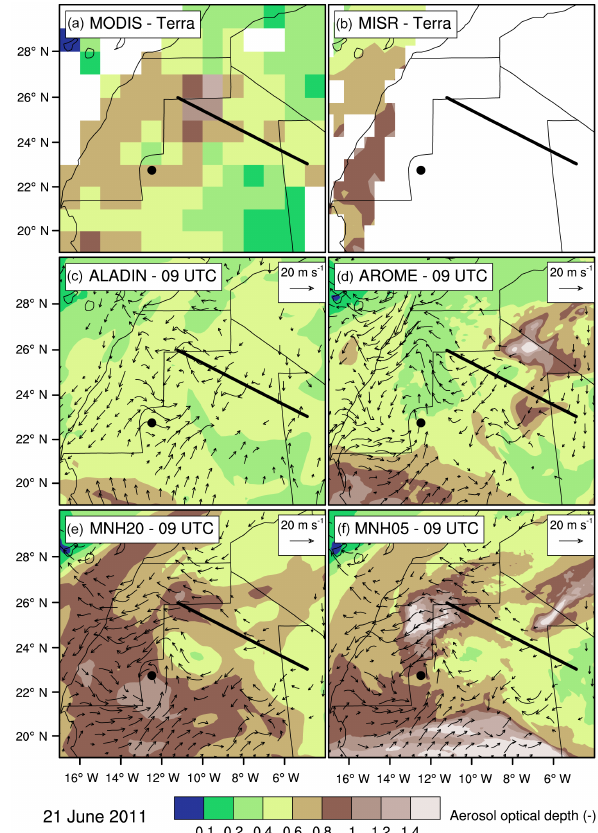
Figure 13. Same as in Fig. 11 but for the F22 flight on 21 June 2011 (leg between 07:58 and